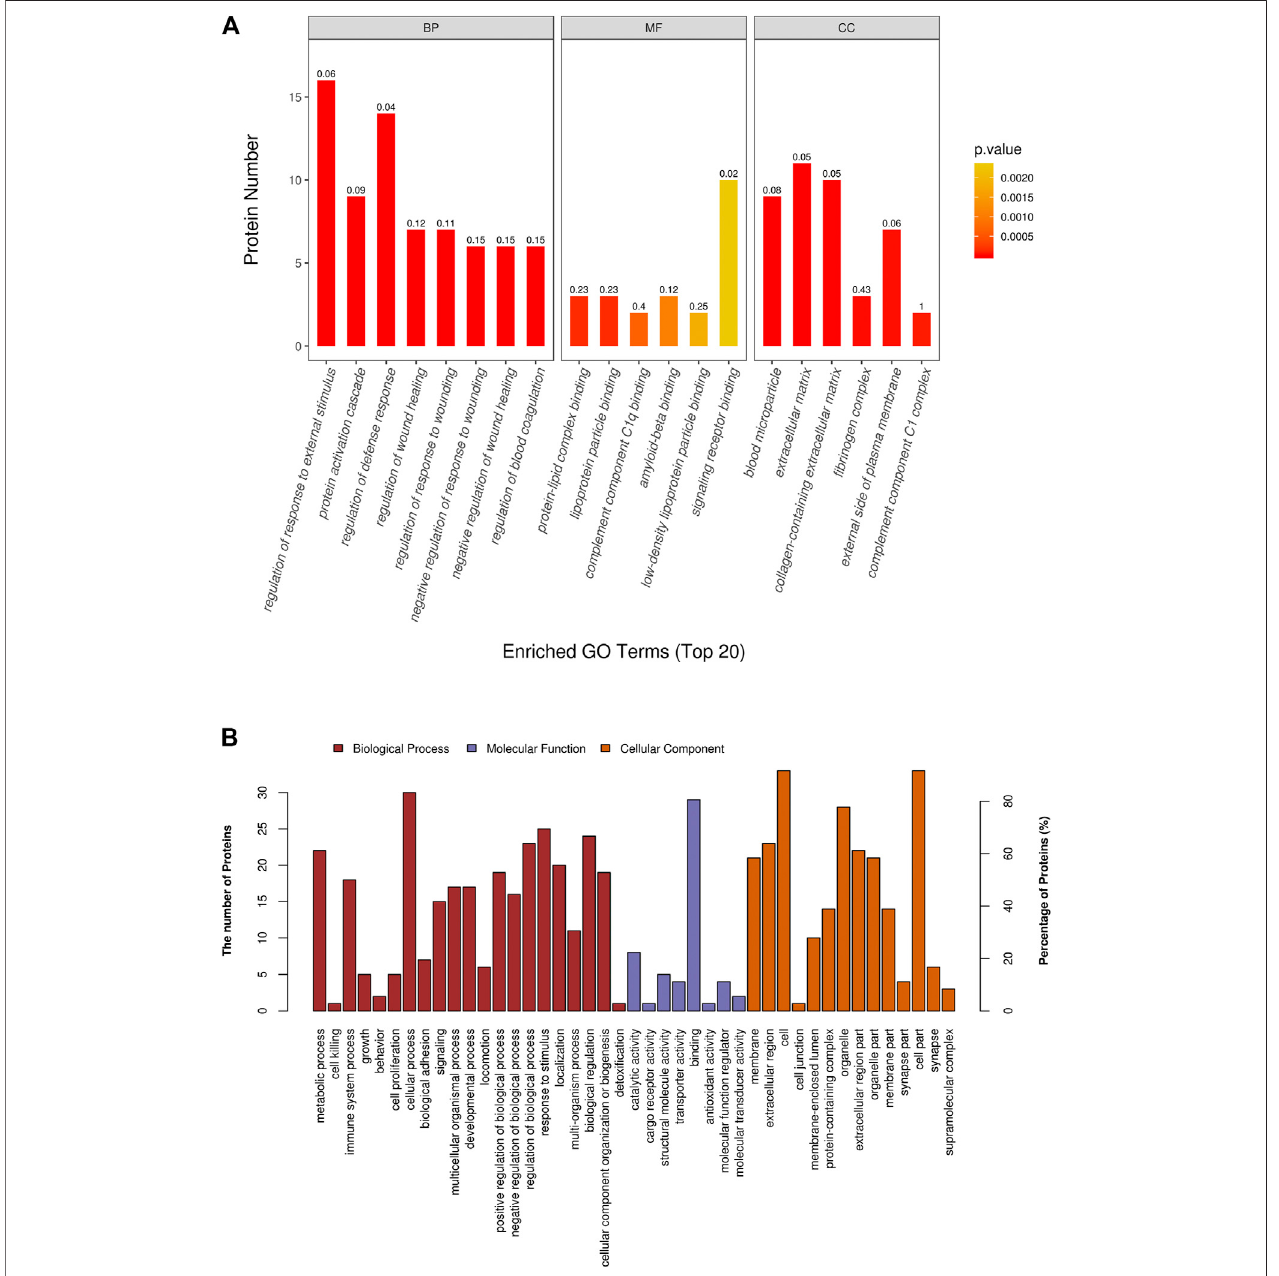
FIGURE3| Geneontology(GO) enrichment analysisofdifferentialabundantproteins. (A) Top 20enriched terms withsmallest p valuesin GOenrichment analysis. (B) All level 2 GO terms involved in GO enrichment analysis.